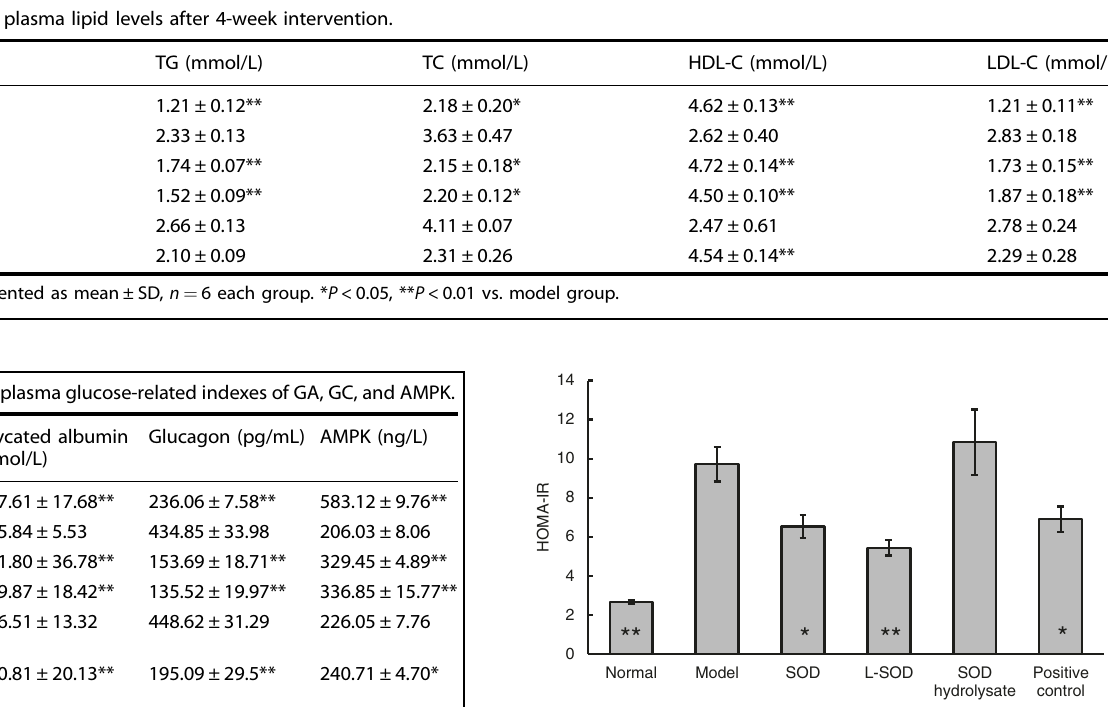
Fig. 4 IR index in rats after 4-week intervention. The data are presented as mean ± SD, n = 6 each group. * P < 0.05, ** P < 0.01 vs. model